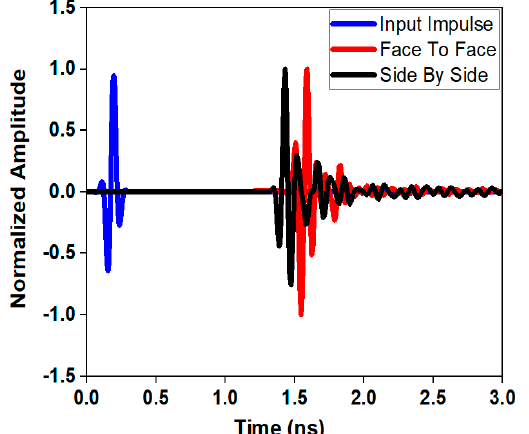
Figure 16. Normalized received pulse for triple band-notched SWB antenna system in face-to-face and side-by-side arrangements.